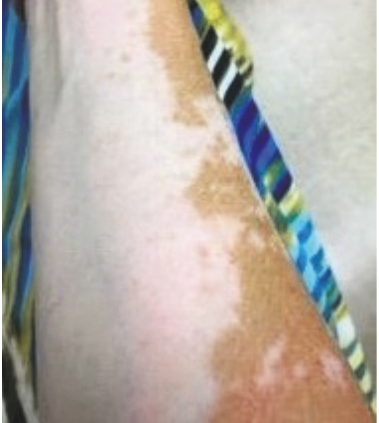
Figure 2: Clinical appearance of the right anterior forearm 5 and a half months after beginning apremilast.